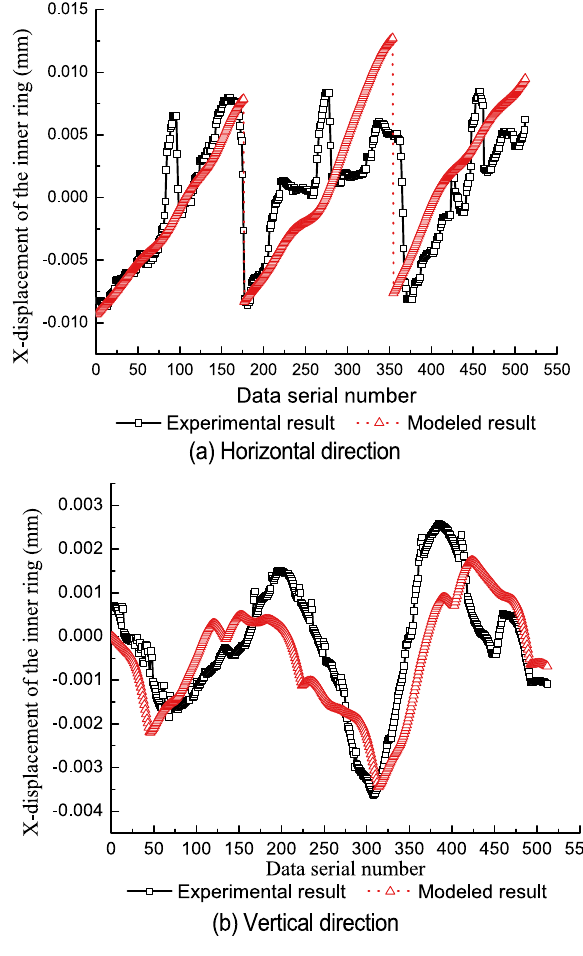
Figure 5. First test bearing comparison between the experimental results and modeled